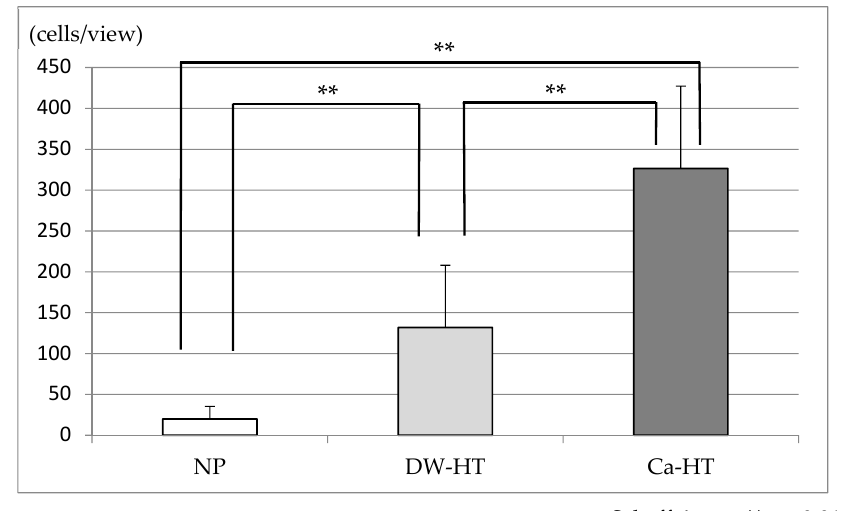
Figure5. AdhesionofMC3T3-E1osteoblasticcellsontothesubstrataafter1hofincubation. Theattached cellcountfortheCa-HTgroupwassignificantlyhigherthanfortheNPandDW-HTgroups. Theattached Figure 5. Adhesion of MC3T3-E1 osteoblastic cells onto the substrata after 1 h of incubation. The attached cell count for the Ca-HT group was significantly higher than for the NP and DW-HT groups. cell count for the DW-HT group was significantly higher than for the NP group ( p < 0.01).